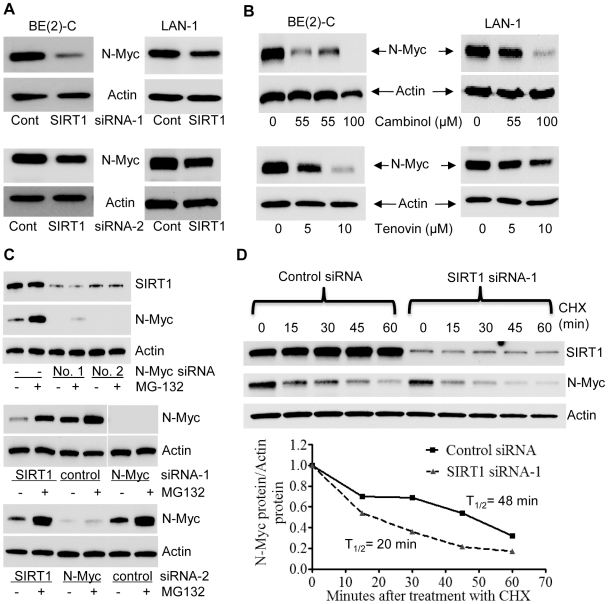
SIRT1 up-regulates N-Myc protein expression by blocking its degradation.(A, B) BE(2)-C and LAN-1 cells were transfected with scrambled control (Cont) siRNA, SIRT1 siRNA-1 or SIRT1 siRNA-2 (A), or treated with the SIRT1 inhibitor Cambinol, Tenovin-6 or vehicle control (B), followed by protein extraction and immunoblot analysis of N-Myc protein. (C) BE(2)-C cells were transfected with scrambled control siRNA, N-Myc siRNA-1, N-Myc siRNA-2, SIRT1 siRNA-1 or SIRT1 siRNA-2 for 48 hours, followed by treatment with the proteasome inhibitor MG-132 (10 µM) for 3 hours. SIRT1 and N-Myc protein expression was analysed by immunoblot. (D) BE(2)-C cells were transfected with scrambled control siRNA or SIRT1 siRNA-1 for 30 hours, and treated with 50 µM cycloheximide (CHX) for the last 0, 15, 30, 45 or 60 minutes. Protein was extracted from the cells and subjected to immunoblot analysis of N-Myc. N-Myc protein level was normalized by actin, the ratio of N-Myc protein and actin protein was artificially set as 1.0 for samples un-treated with CHX, and half life (T1/2) of N-Myc protein was obtained from the line chart.